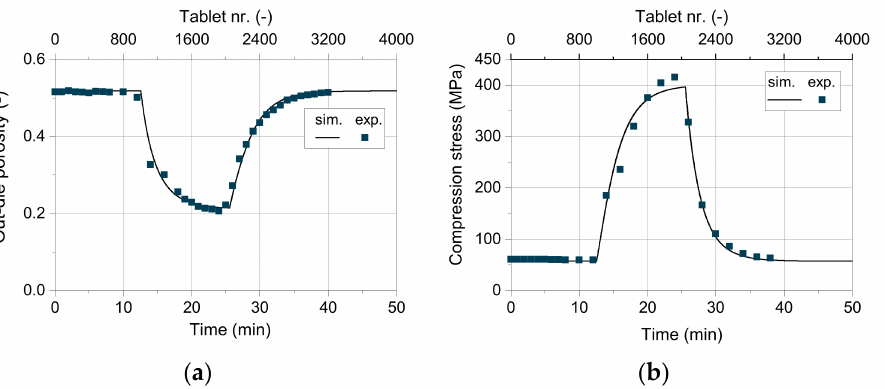
Figure 14. Comparison of the simulative data with experimental results for ( a ) the out-die porosity and ( b ) the compression